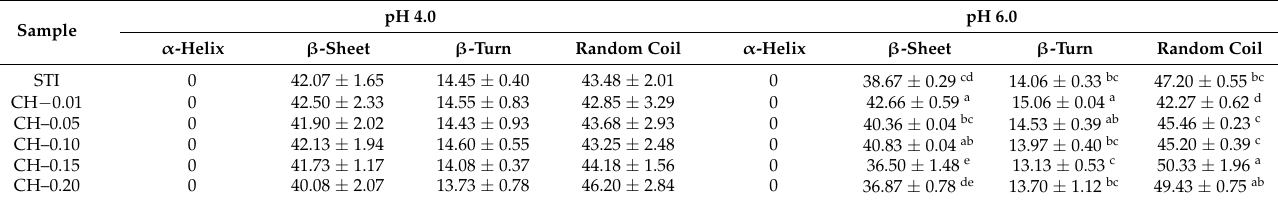
Figure 5. The effect of CS concentration on the CD spectra of STI at pH 4.0 and 6.0. Figure (cid:561) 5. (cid:561) The (cid:561) e (cid:283) ect (cid:561) of (cid:561) CS (cid:561) concentration (cid:561) on (cid:561) the (cid:561) CD (cid:561) spectra (cid:561) of (cid:561) STI (cid:561) at (cid:561) pH (cid:561) 4.0 (cid:561) and (cid:561) 6.0. (cid:561) Table (cid:561) 2. (cid:561) The (cid:561) e (cid:283) ect (cid:561) of (cid:561) CS (cid:561) concentration (cid:561) on (cid:561) the (cid:561) secondary (cid:561) structure (cid:561) of (cid:561) STI. (cid:561) Table 2. The effect of CS concentration on the secondary structure of